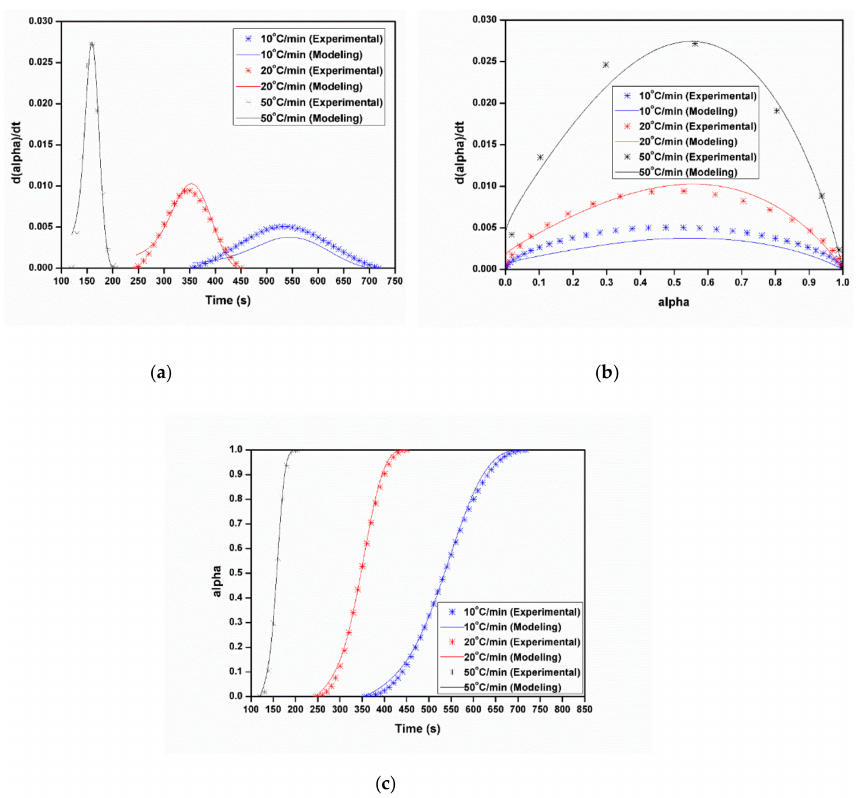
Figure 13. Comparison of modeling results to experimental data using exponential fitting parameters: ( a ) 10 ◦ C / min, ( b ) 20 ◦ C / min, ( c ) 50 ◦ C /